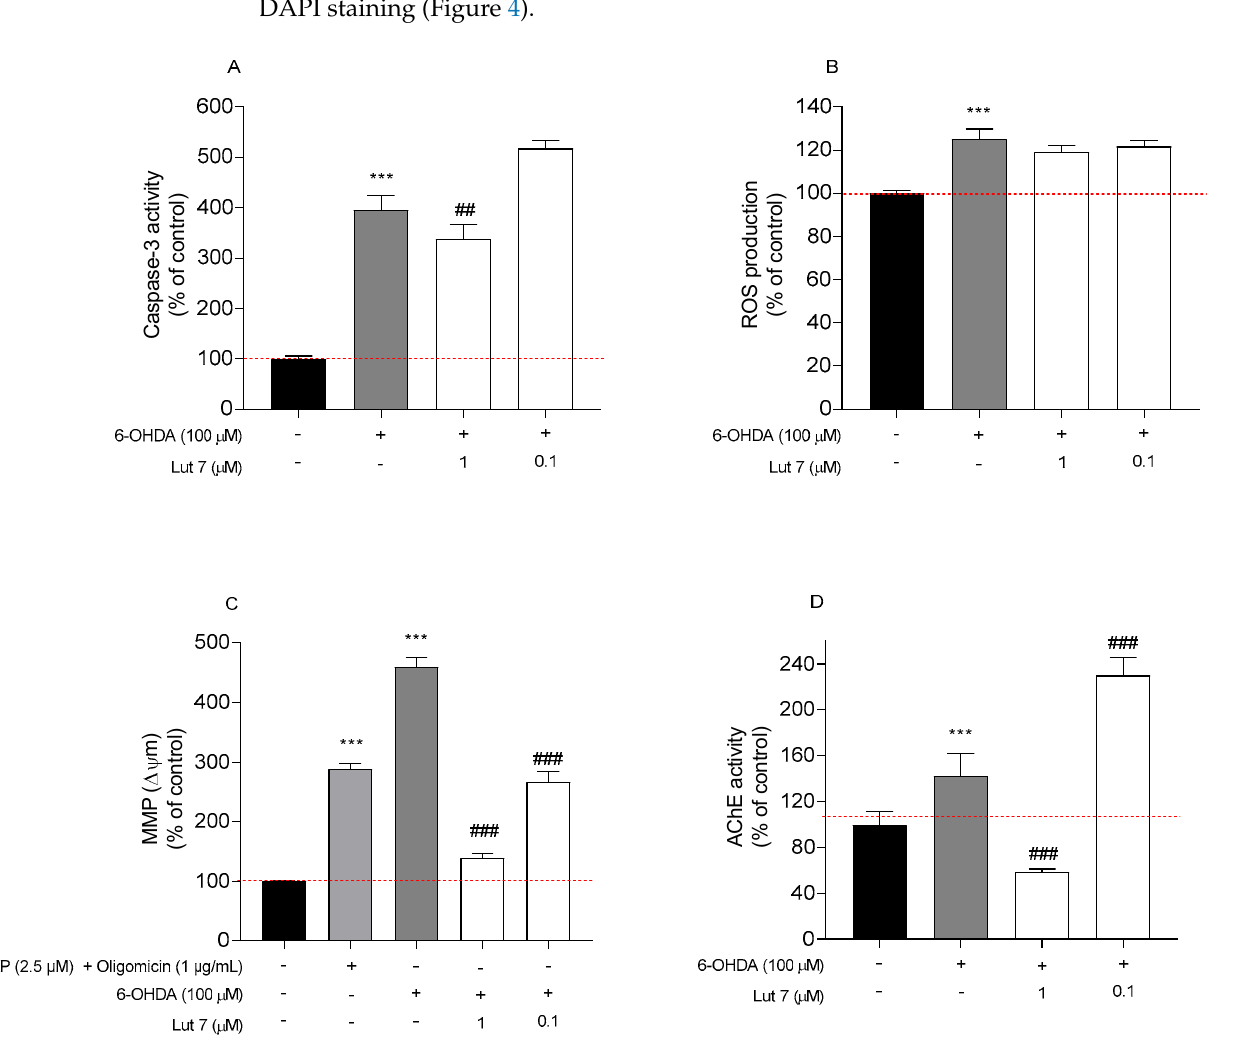
Figure 3. Effect of Luteolin-7-O-glucoside (Lut7) on SH-SY5Y cells after exposition to 6-OHDA (100 µ M) over 6 h. ( A ) Effect on Caspase-3 activity ( ∆ Fluorescence (U.A)/mg of protein/min); ( B ) ROS production; ( C ) MMP (ratio of monomers/aggregates of JC-1); and ( D ) AChE activity (nmol/min/mg of protein). The values in each column represent the mean ± standard error of the mean (SEM) of at least 3 independent experiments carried out in triplicate. Statistical calculations were performed with ANOVA via the Tukey post hoc test and significant differences were considered for *** p < 0.001 (vs. control); ### p < 0.001 and ## p < 0.01 (vs. 6-OHDA). Negative control (untreated cells) was considered to be 100% viable and is represented by the red dashed line. DMSO 0.1% was used as a vehicle.